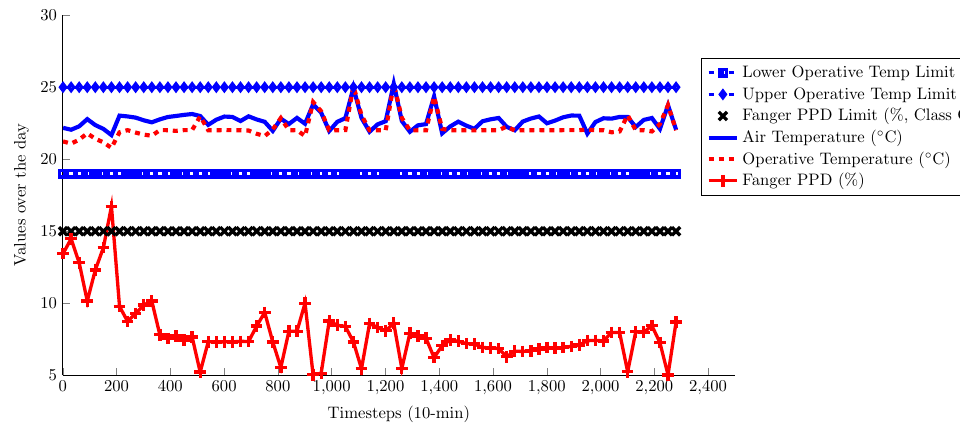
Figure 13. Winter results for Office 04 using operative temperature thermostat set at 22 ◦